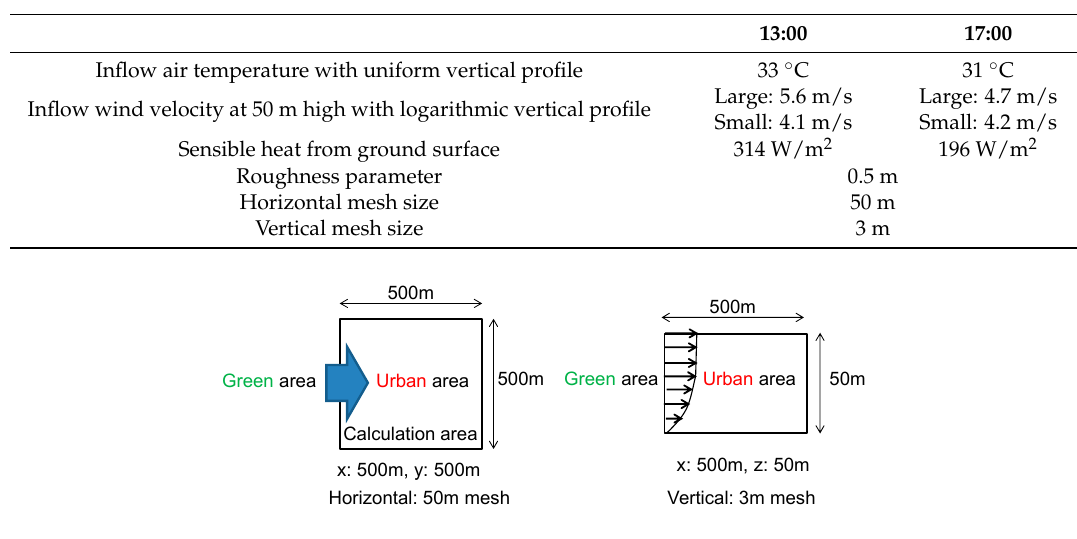
Figure 4. Outline of calculation conditions.